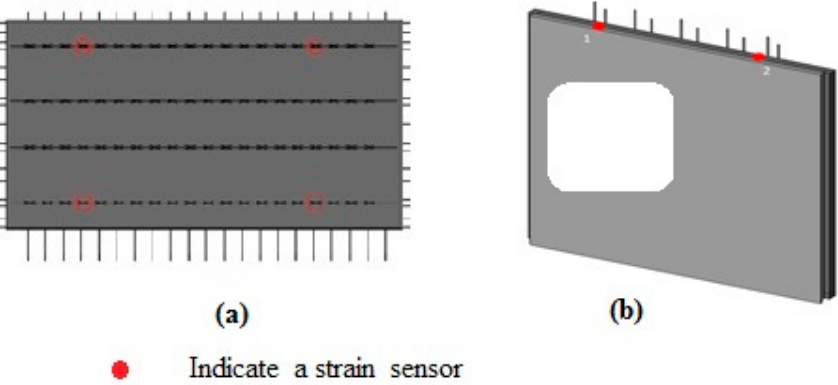
Figure 21. ( a ) BIM model of a PC slab; ( b ) BIM model of a PC wall panel.